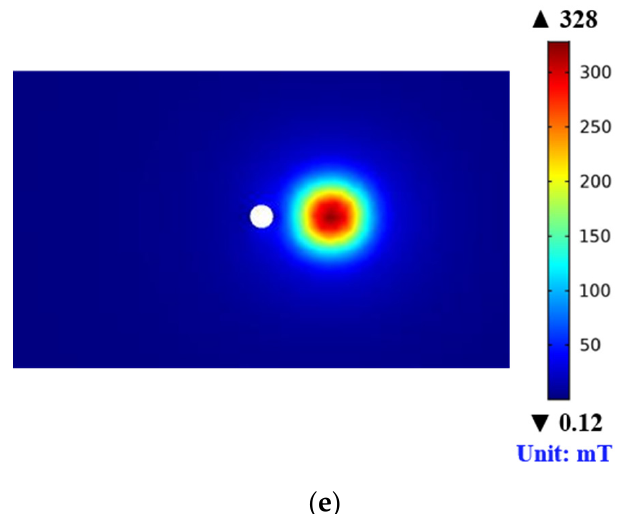
Figure 7. Numerical results of the magnetic flux density distribution when the defect is at different positions: ( a ) x = − 1.5 mm, ( b ) x = − 0.5 mm, ( c ) x = 0 mm, ( d ) x = 0.5 mm and ( e ) x = 1.5 mm (top